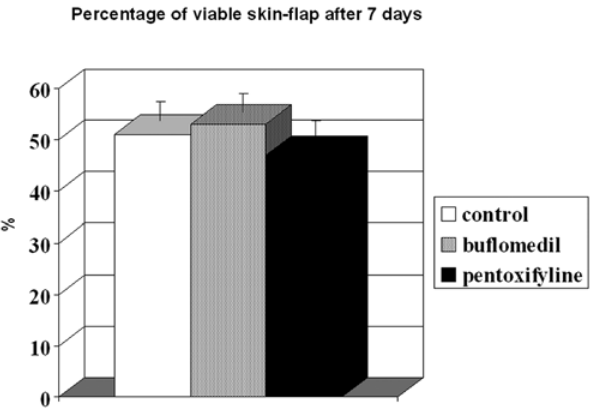
Figure 5 - Viable skin flap area on the seventh post-operative day